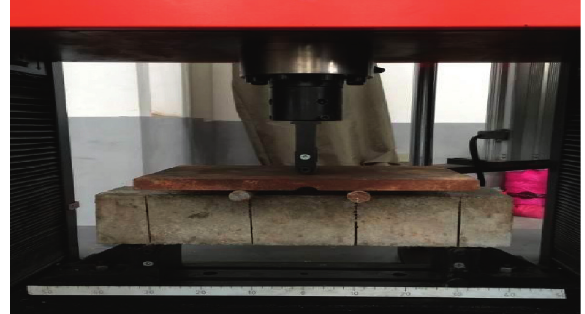
Figure 2: Flexural test of sisal fiber husk.